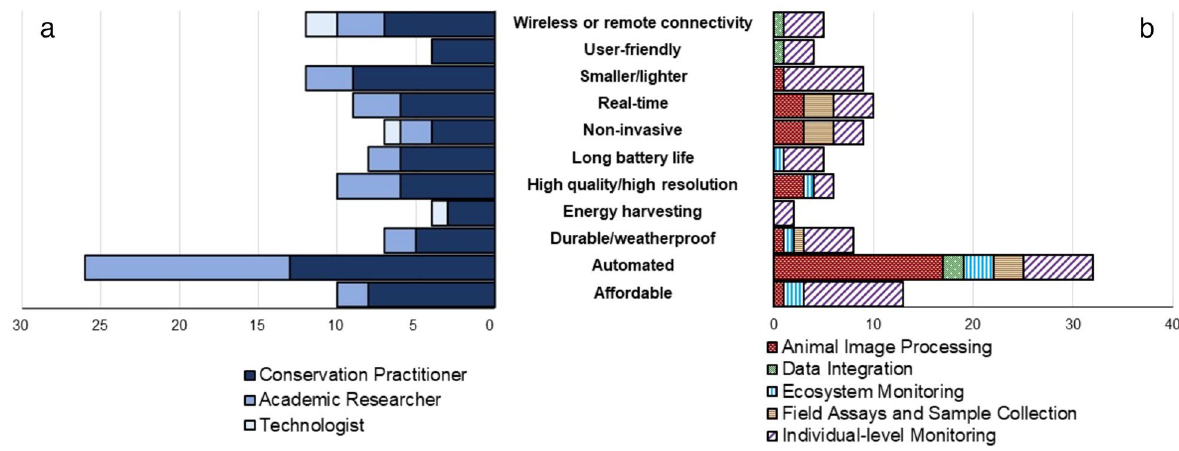
Figure 2. Categories of improvements to existing technology identified by occupation group and application type. The x-axis denotes the counts of respondents. Answers were derived from a theme analysis of the open- ended survey question “Assuming unlimited funding and resources, what technological solution would you want to see developed?”. Theme analysis codebooks can be found in SM Appendix 2 Table 9 and